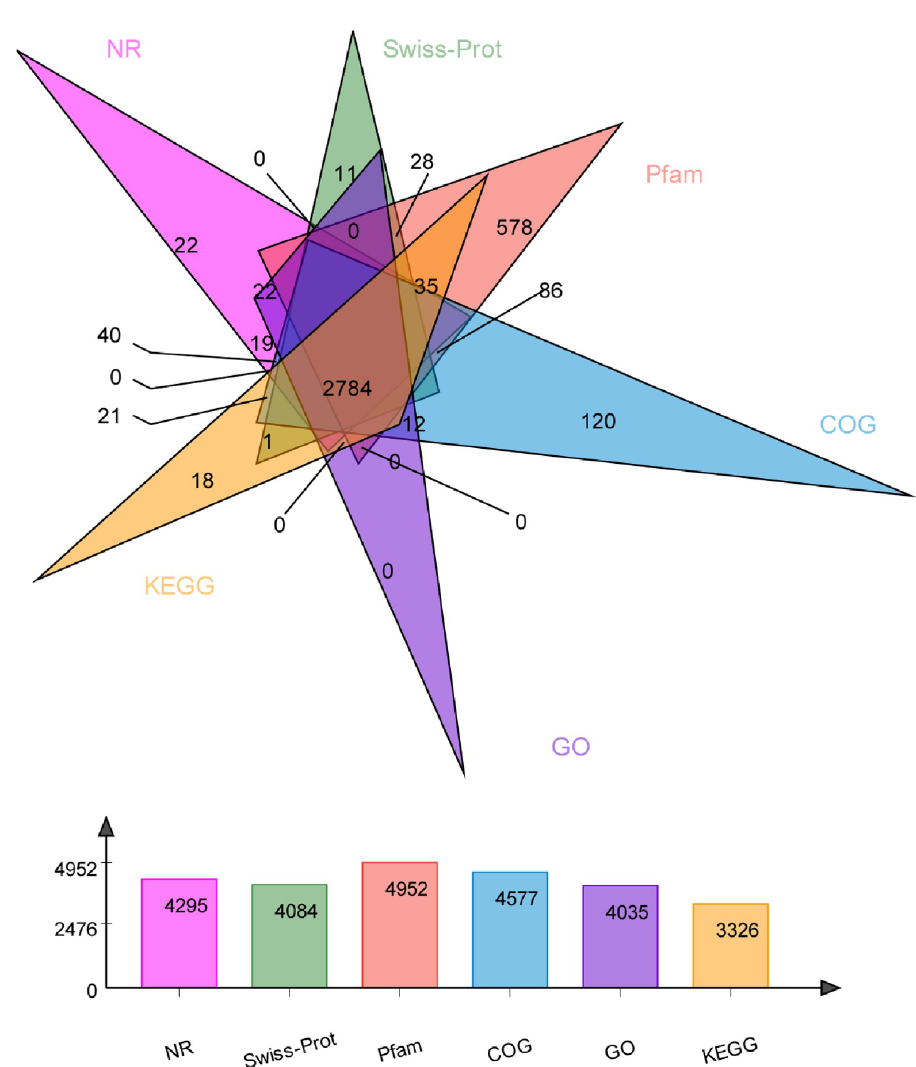
Fig 2. Venn diagram and number of annotated unigenes using different database. Below database was used to annotate unigenes. Nr: NCBI’s non-redundant database. GO: Gene Ontology. EC number and KO: The annotation results of KEGG (Kyoto Encyclopedia of Genes and Genomes) database. COG: Clusters of Orthologous Groups (COG) database. Swiss-Prot: A manually annotated and reviewed protein sequence database. Pfam: Protein family. Each figure represents the number of annotated unigenes in corresponding